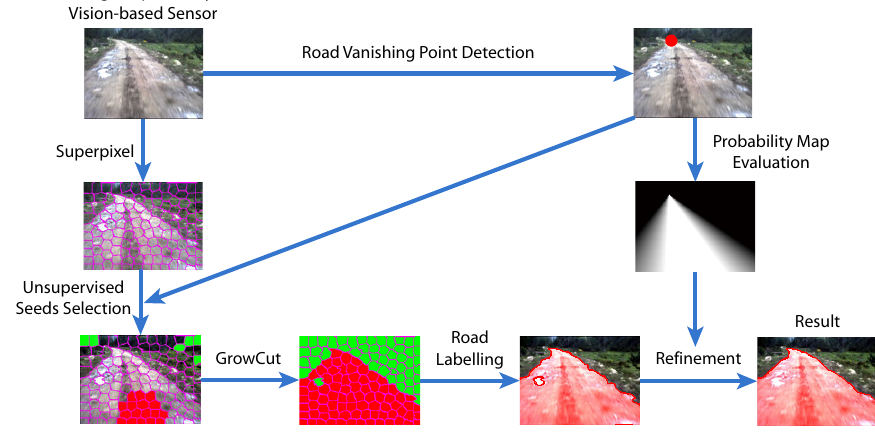
Figure 1. Diagram of our vision sensor-based road detection